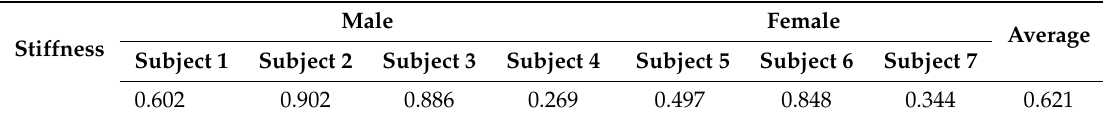
Table 2. Stiffness test results (N/mm).